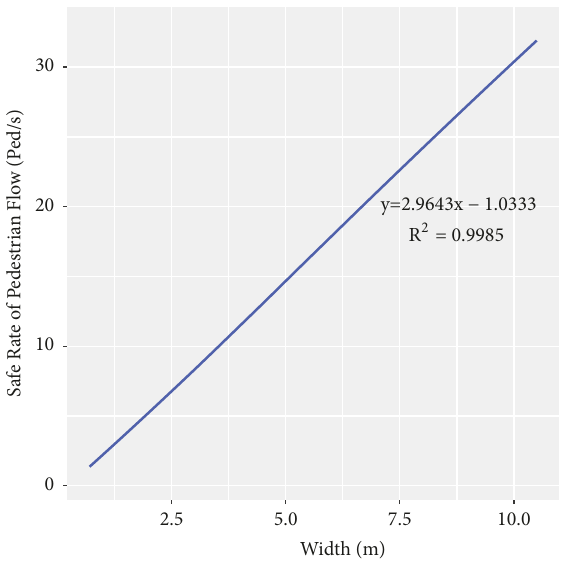
Figure 12: Safe pedestrian flow rate varying over tunnel